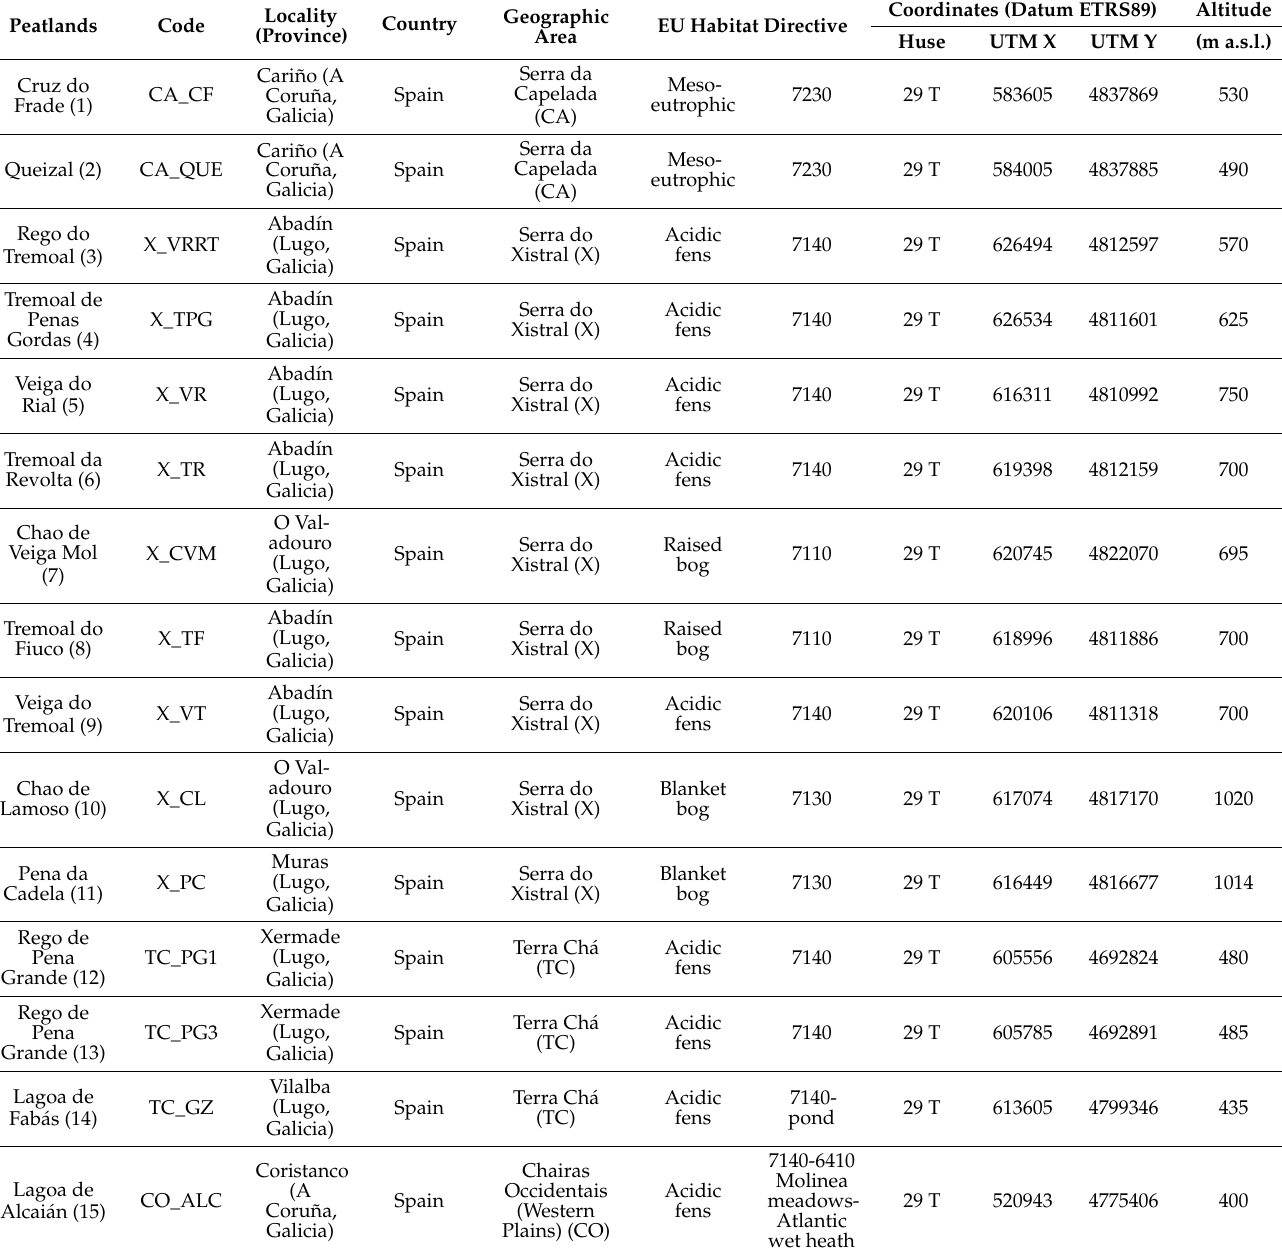
Table 1. Location and typologies of the studied Iberian